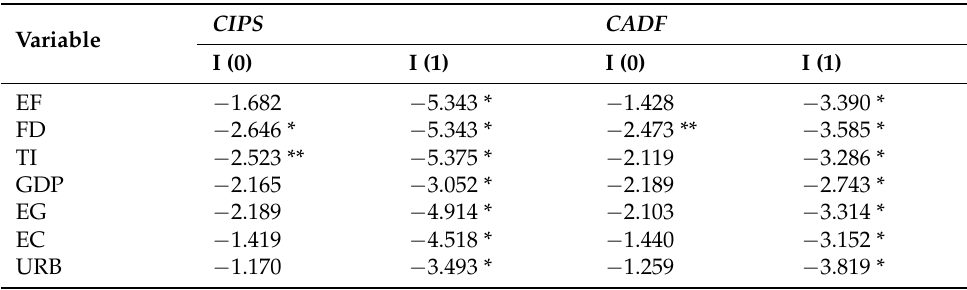
Table 4. Unit root test results.